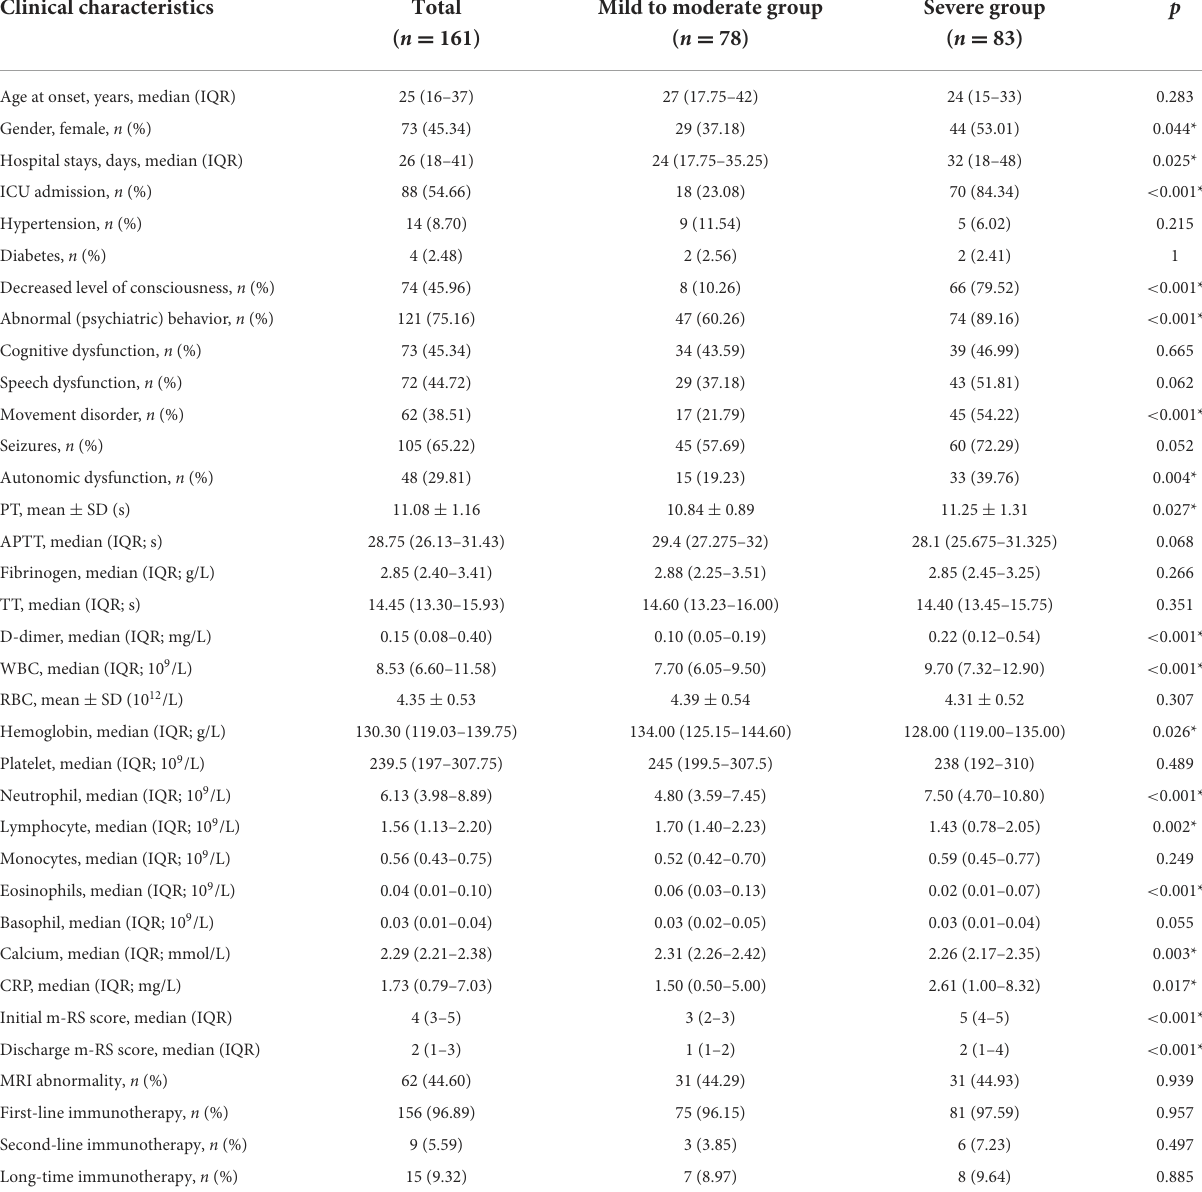
TABLE 2 Clinical characteristics of the patients with anti-NMDAR encephalitis severe group and mild to moderate group. Clinical